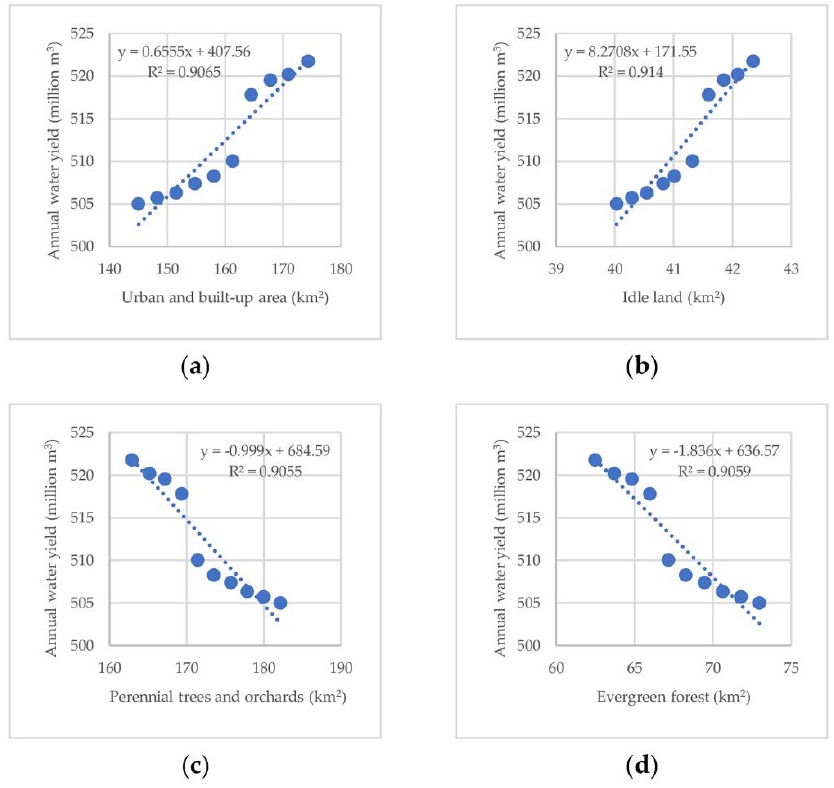
Figure 12. Simple linear regression analysis between LULC type and water yield under dry year scenario.